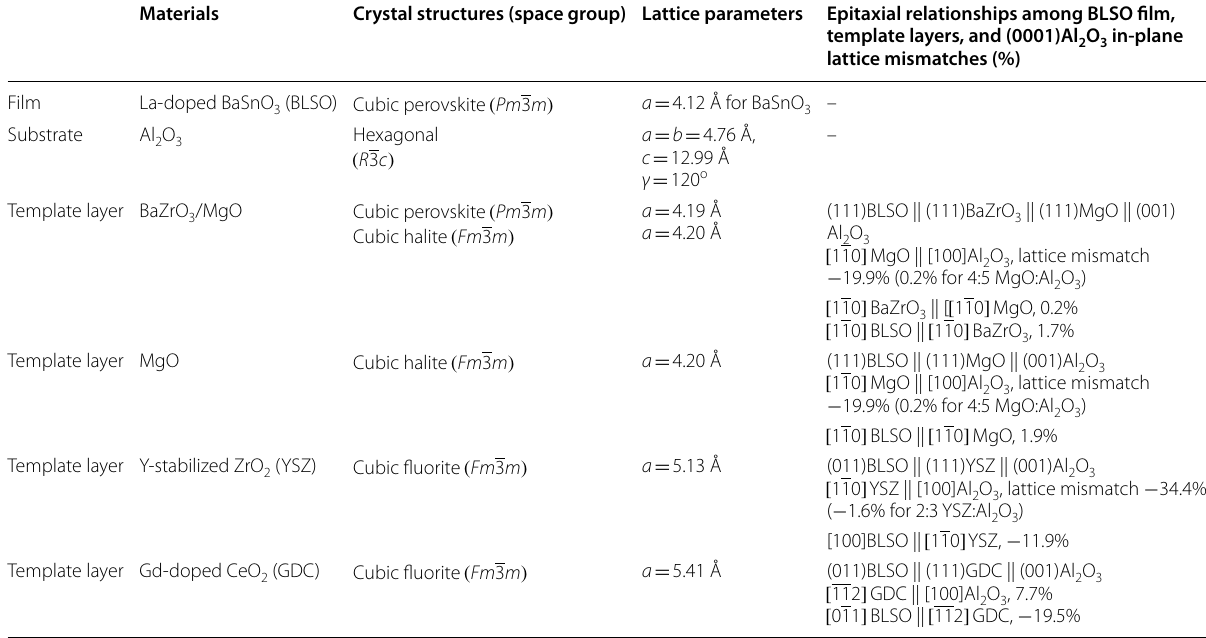
O substrate, and in-plane lattice 2 3